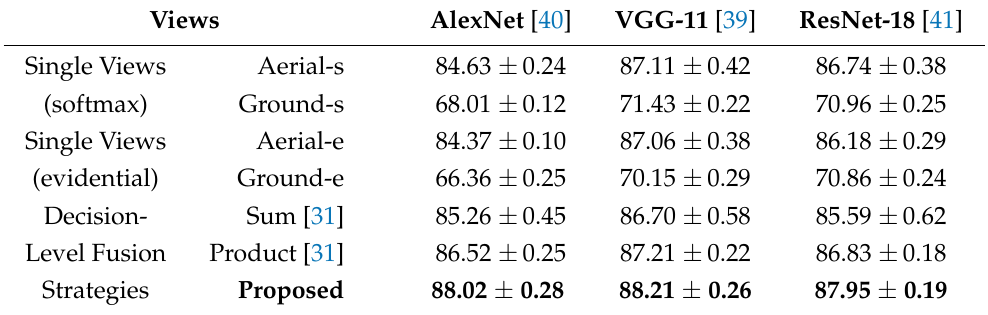
Table 4. Classification accuracy (%) ± STD of single views and after decision-level fusion on